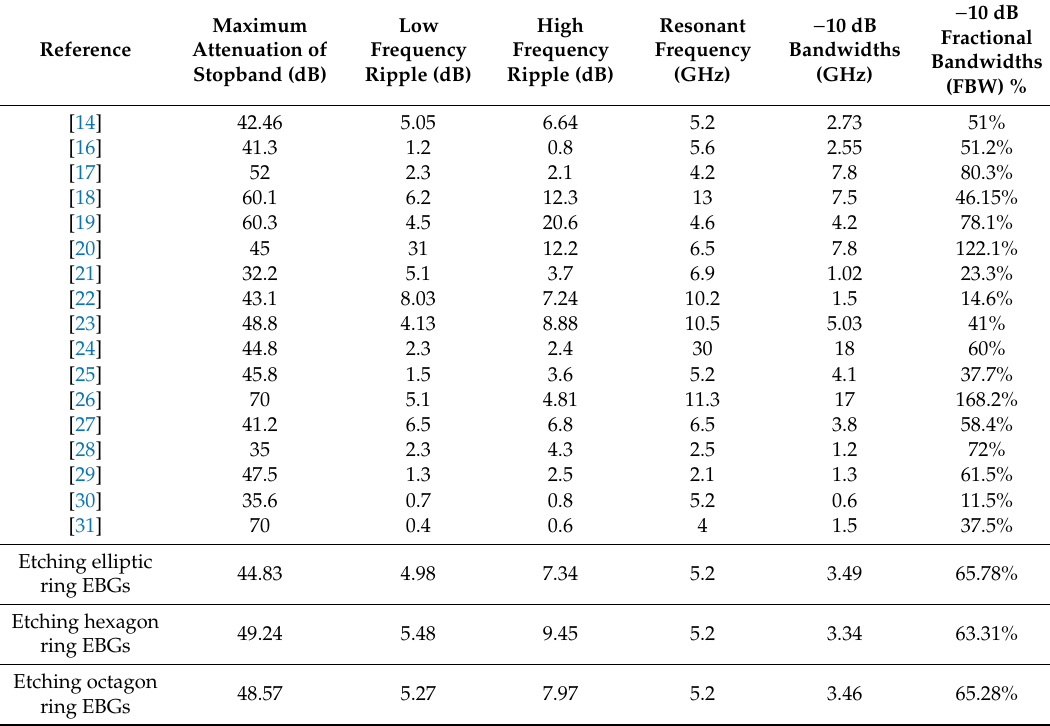
Table 2. Comparison of the proposed filter with other band stop